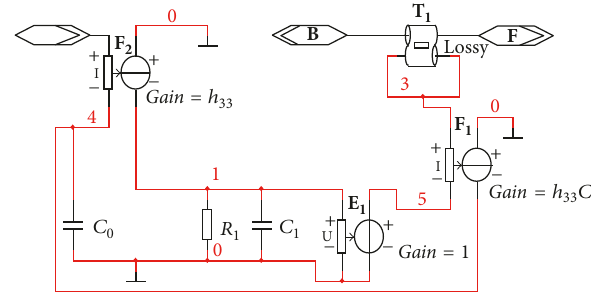
Figure 2: Leach’s equivalent circuit model for a piezoelectric